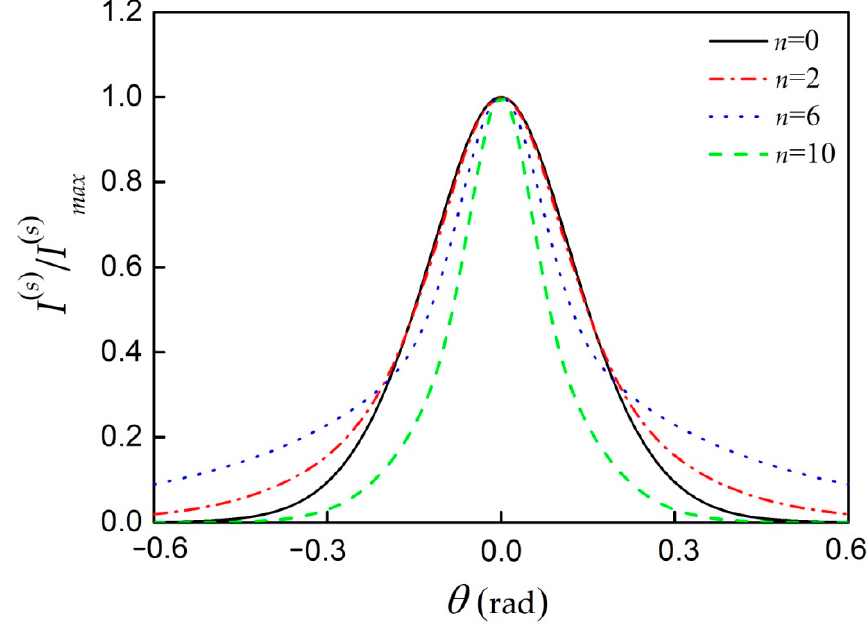
Figure 2. Normalized intensity of scattered pulse as function of scattering angle θ for four different values of parameter n .